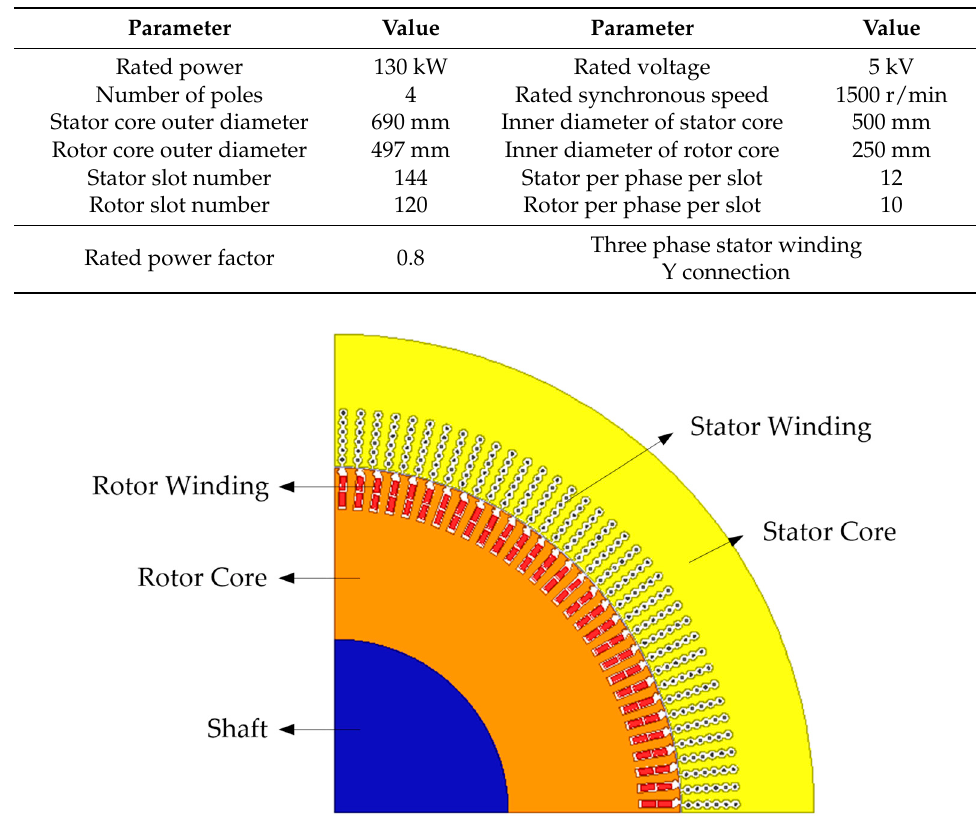
Figure 1. Physical model of the asynchronized high-voltage generator.